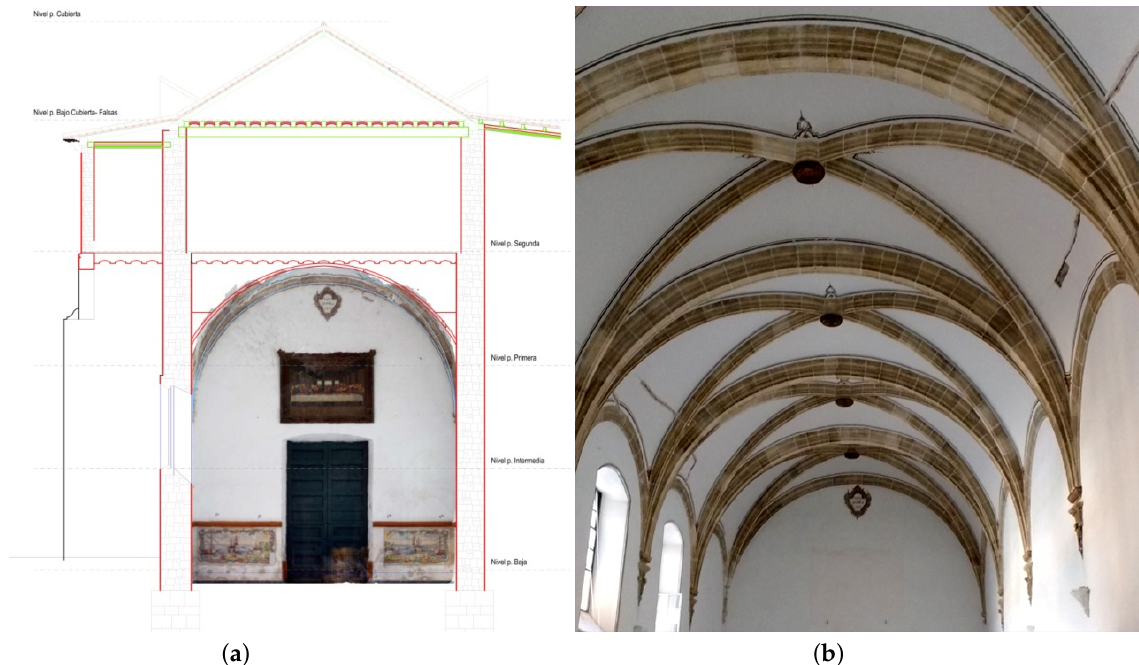
Figure 2. The spatial distribution of arches and vaults in the refectory area. ( a ) the sketch of vertical cross-section ( b ) vaults directional